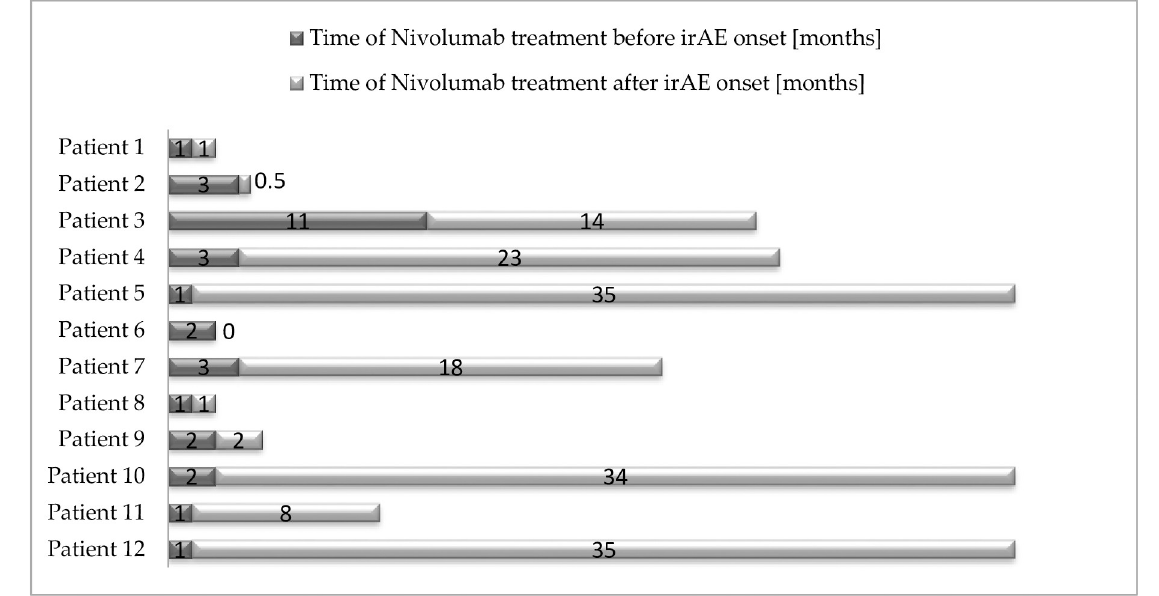
Fig 1. Landmark analysis of patients with endocrine irAE. (Patient number 6 developed irAE 2 weeks after treatment termination).